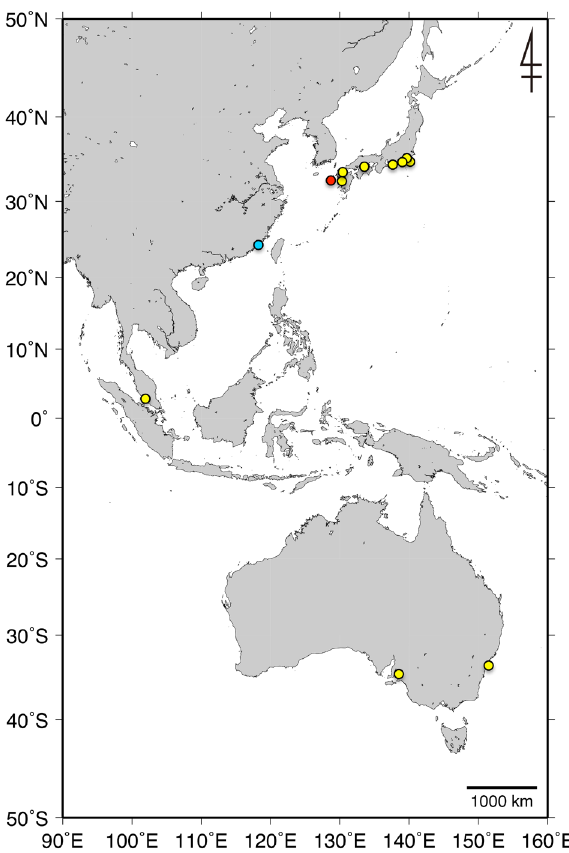
Figure 1. Known distribution of Halla okudai . The red circle indi- cates the record of the present study, whereas yellow circles are records of other reports (Okuda 1933a; Itazaki 1982a; Saito and Imabayashi 1997; Saito et al. 1999, 2007, 2014; Biodiversity Center of Japan 2007; Idris and Arsha 2013; Tanaka and Sato 2020; T. Ojima pers. comm.; M. Taru pers. comm.). The blue circle indicates Xiamen (Amoy), Fuijian Province, China, based on the import information of the species from Xiamen to Japan (Saito et al.